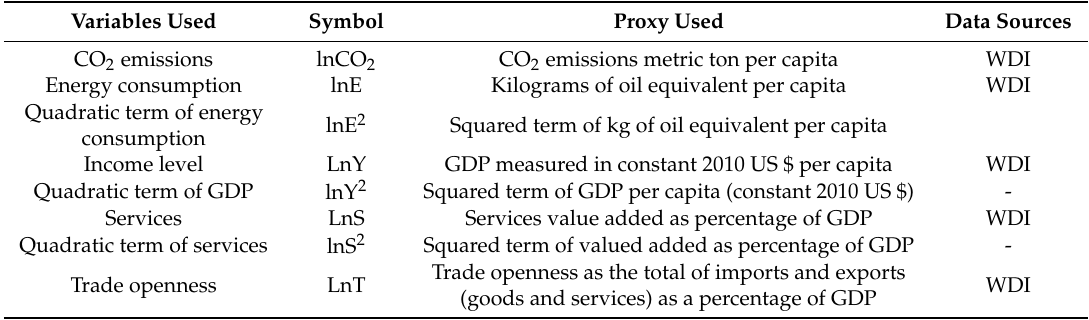
Table 2. Variable description and measurement. GDP—gross domestic product; WDI—World Development Indicator; US—United